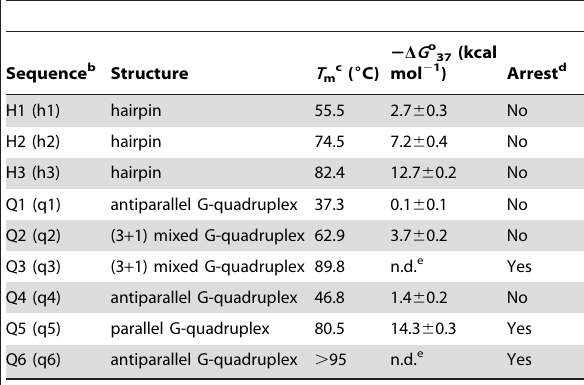
Table 1. The stabilities of non-canonical structures designed to form in template DNA a